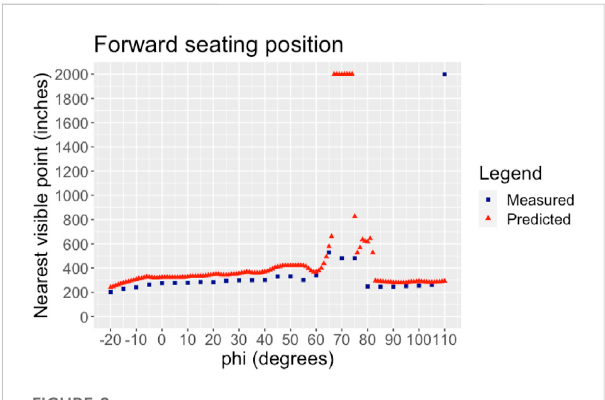
FIGURE 8 Forward seating position: Measured and predicted.